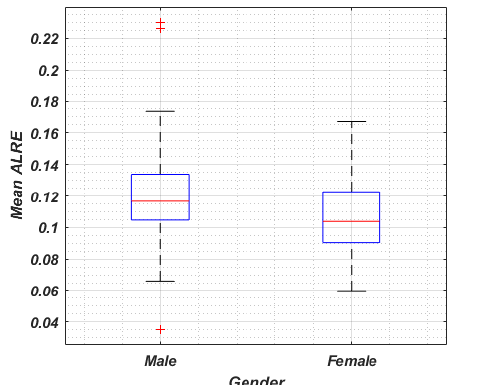
Figure 8. The relative performance of male and female experts in making economic forecasts. The Y–axis range was cropped to make the differences more